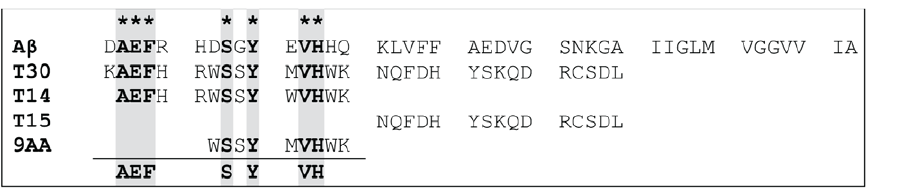
Figure 1. Alignment of the sequences of b -Amyloid (A b ) compared with the AChE C-terminus peptides of 30 amino acids (T30), 14 amino acids (T14), and the residual 15 amino acid sequence between the two (T15). Note homology between the 9 amino acid sequence (9AA) possible in human plasma and T14, T30 and A b (shaded panels), but not T15.